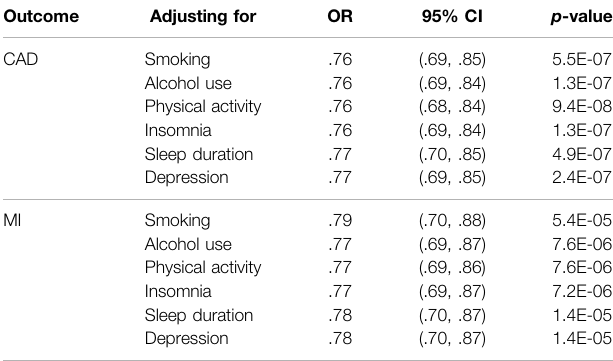
TABLE 3 | Multivariable Mendelian randomization analyses of genetically determined intelligenceandtheriskofcoronaryarterydiseaseandmyocardial infarction adjusting for potential confounding